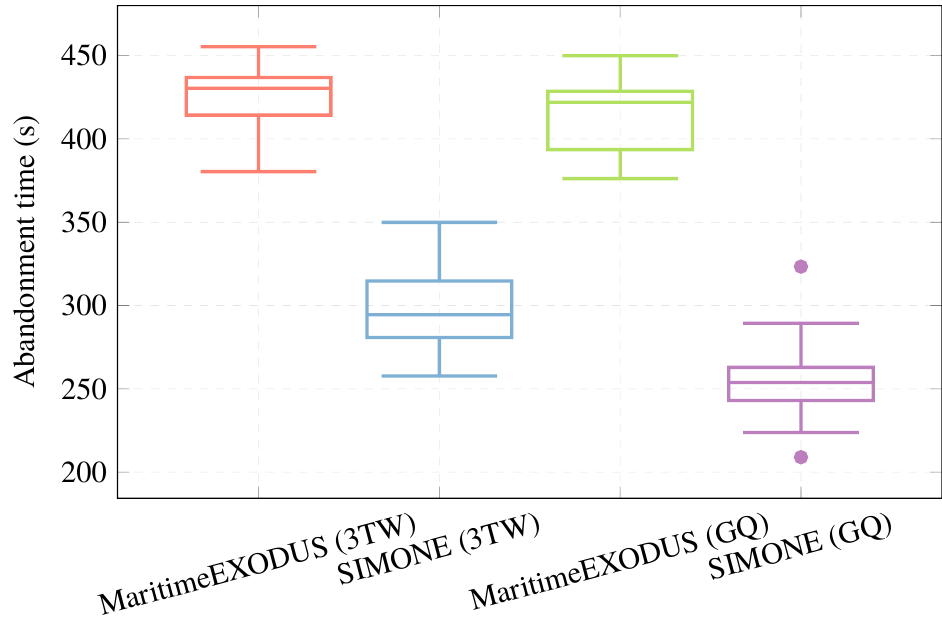
Figure 7. Box plots, abandonment times (MaritimeEXODUS vs. SIMONE) for the 3 TW and GQ starting